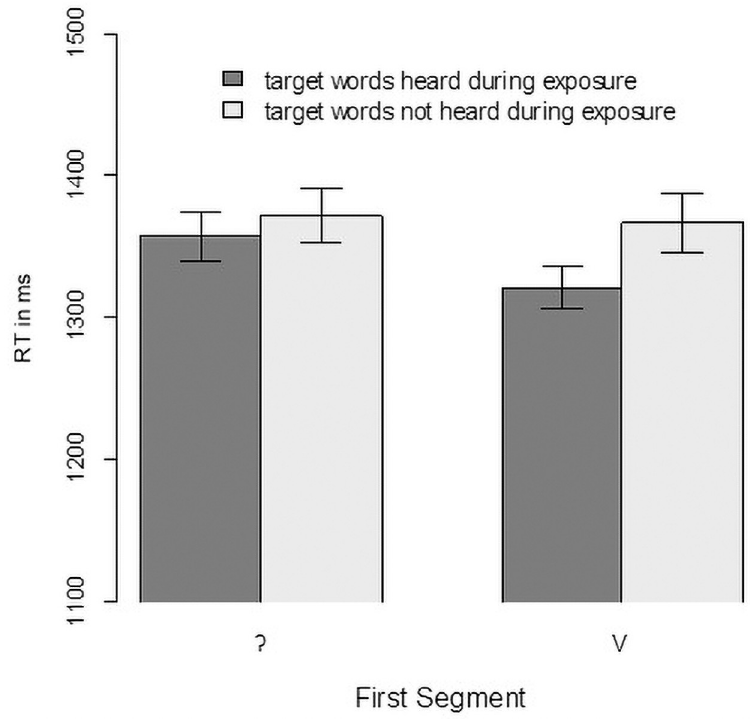
Fig 4. Mean reaction times in milliseconds in Experiment 2. Note that Mean reaction times (RT) and error bars were calculated on log(RT) and then transformed back to raw RT for easier readability. Error bars indicate the standard error for within-participant designs [53].